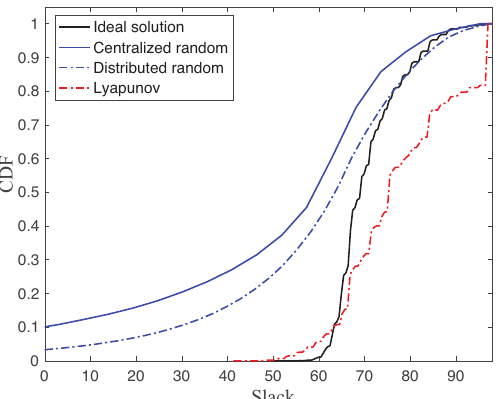
Figure 6. CDF of slack of ideal solution, centralized random access, distributed random access, and Lyapunov-based approach with N =